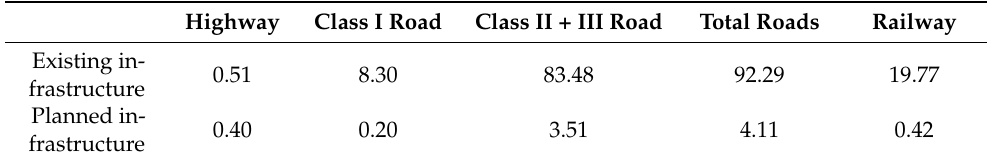
Table 9. The proposed transport network changes and the current infrastructure to be flooded with planned lakes